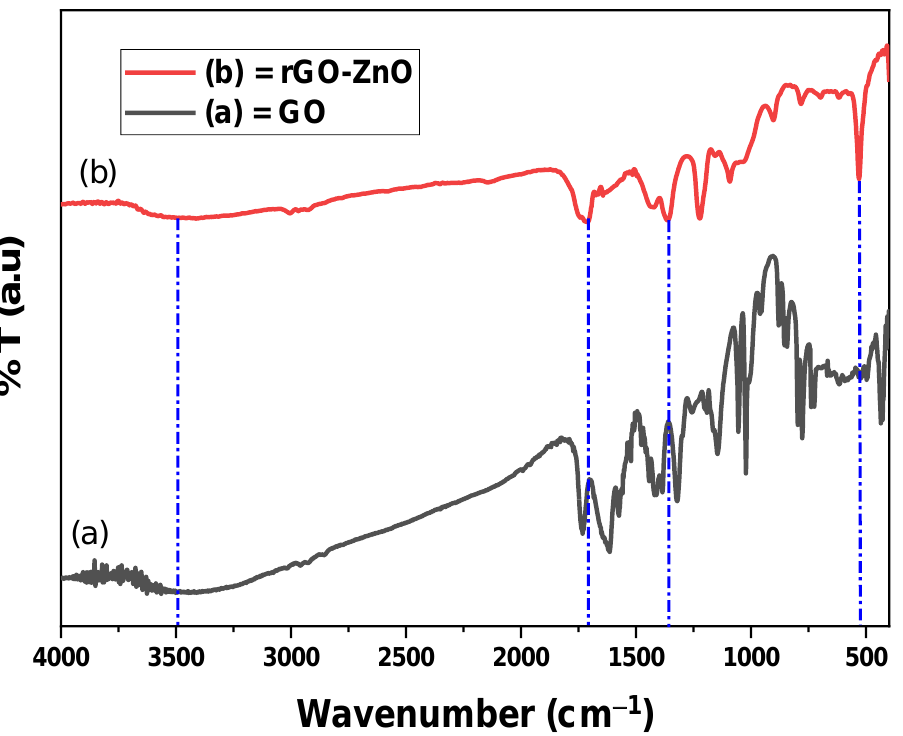
Figure 3. The FT-IR spectra of GO and rGO-ZnO.